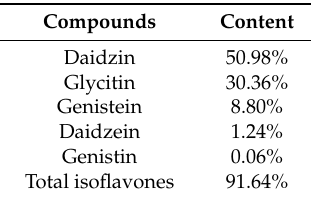
Table 3. Composition of the soy isoflavone